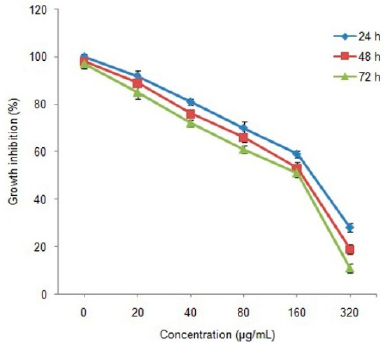
Figure 5. Growth inhibition of 4T1 murine breast cancer cells exposed to synthesized MnFe 2 O